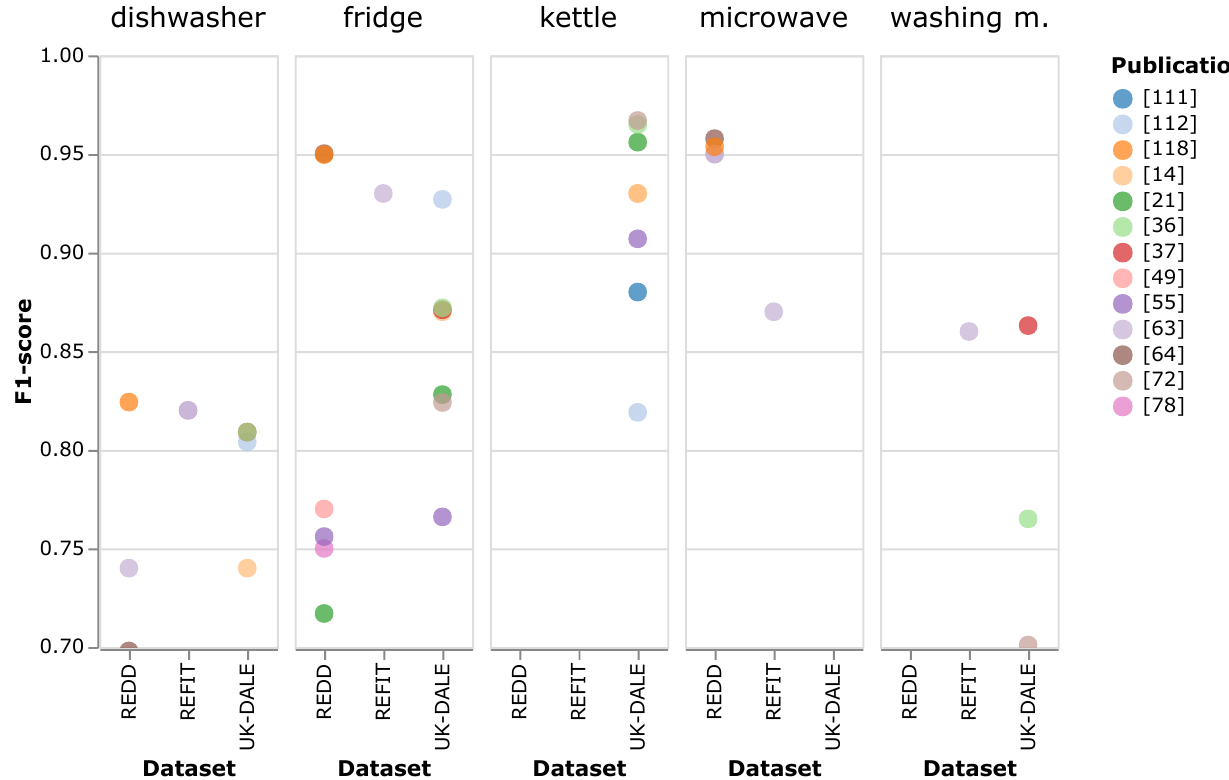
Figure 4. Maximal reported F 1 -score for the corresponding dataset and appliance. Only results from the observed , unseen evaluation scenario have been included. Only approaches proposed by the authors in the corresponding publications are taken into consideration (i.e., no baselines or models from the state-of-the-art). Results have been split according to the appliance and employed dataset. Please note that appliances with a single result in the selected range are not